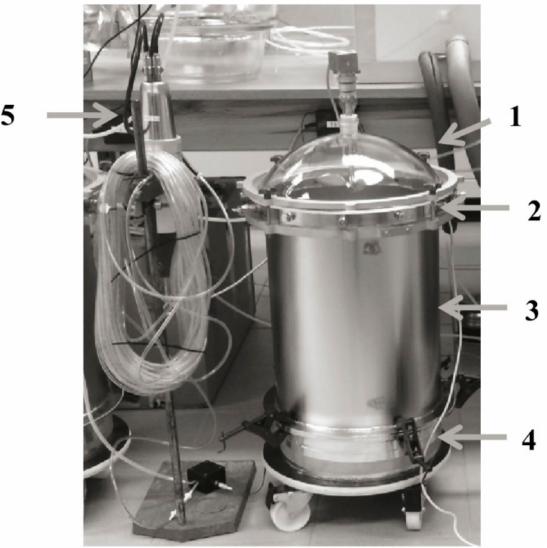
Figure 2. Emission test chamber assembly with Lucas scintillation cell for radon measurement: ( 1 ) glass lid with agitator, ( 2 ) connection ring, ( 3 ) hollow cylinder, ( 4 ) sample intake, ( 5 ) Lucas